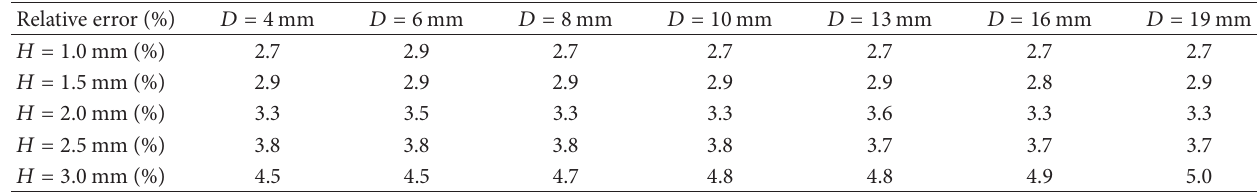
Table 2: Surface area measurement error for cylinder cavity.